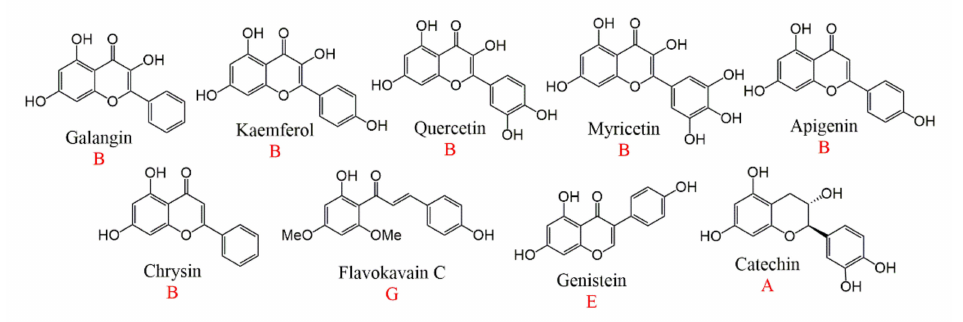
Figure 12. The structure of